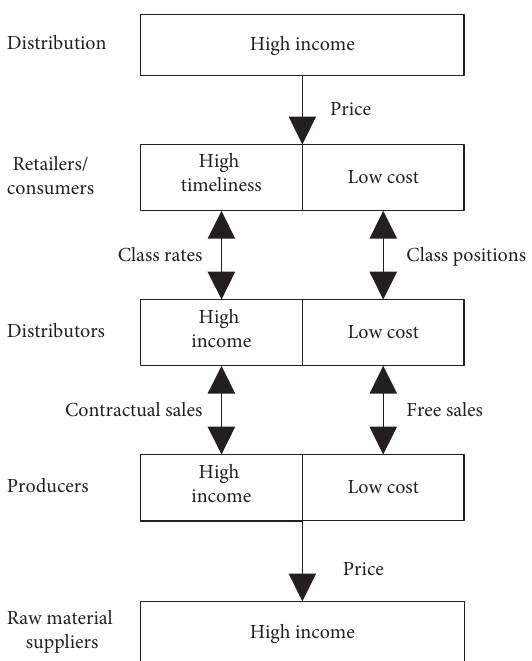
Figure 2: Game logic of the complex system for the GSCDN.